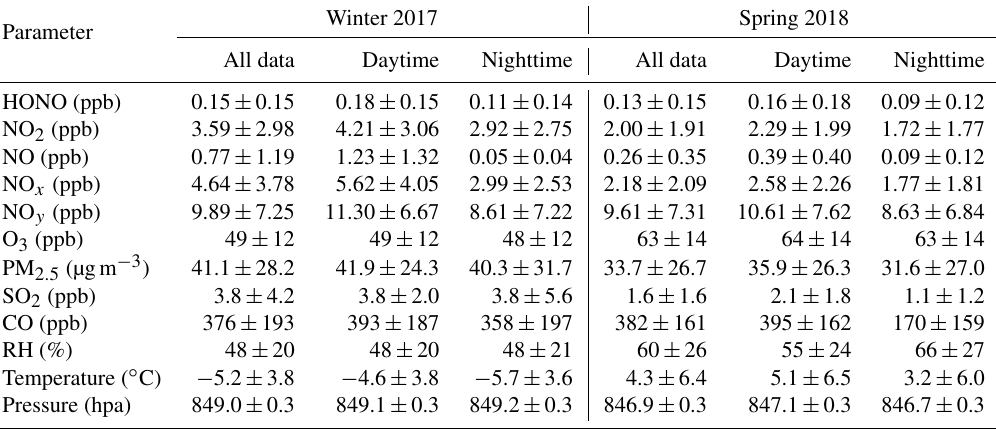
Table 1. Statistics (average ± standard deviation) of trace gases, PM 2 . 5 , and meteorological parameters measured at Mt. Tai in winter 2017 and spring